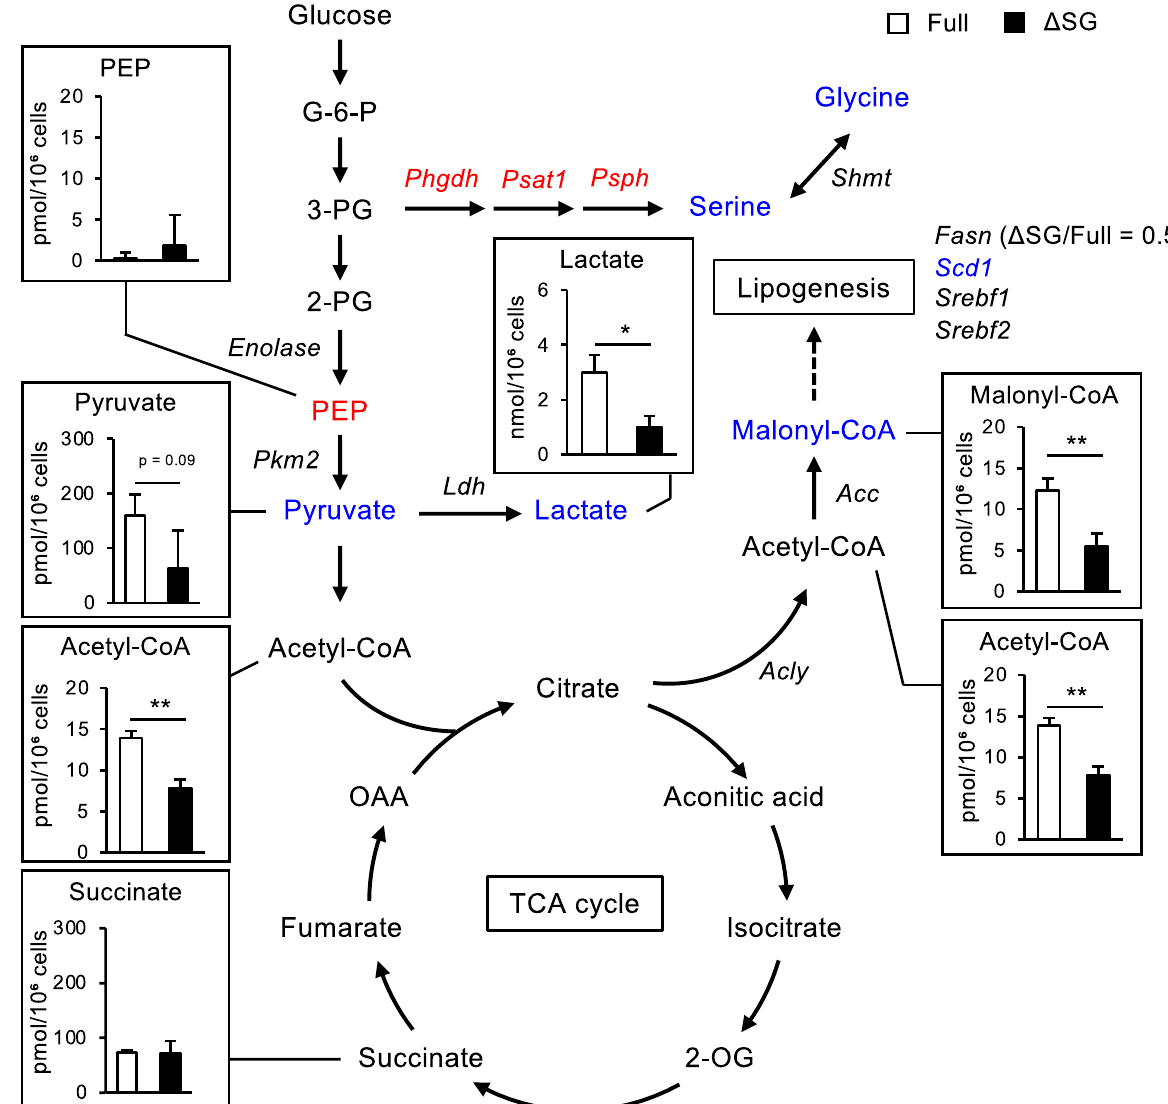
Figure 3. Serine and glycine deprivation alters cellular metabolism in macrophages. Transcriptomic and metabolic profiling in periMΦs cultured in Full or ∆SG medium for 24 h. Genes and metabolites whose expression and abundance were increased in ΔSG medium compared with Full medium (≥ 2.0) are highlighted in red, and those whose expression and abundance were decreased in ∆SG medium (≤ 0.5) are highlighted in blue. Gene names are indicated in italics. Values are means ± 95% CI. n = 3 and n = 4 for metabolomic and transcriptomic analyses, respectively. Statistical analysis was performed with Student’s t test. * p < 0.05; ** p < 0.01. See also Supplementary Figs. S5 and